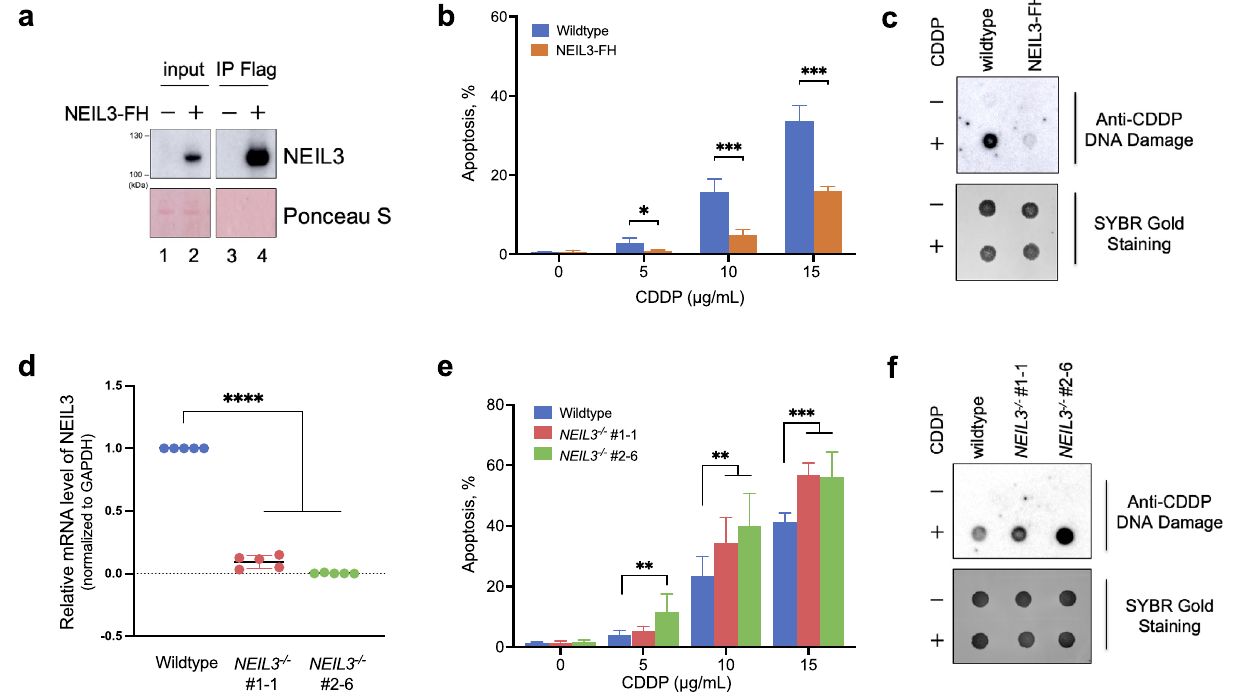
Figure 1. NEIL3 is involved in the repair of cisplatin-induced DNA lesions and protects human cells from cisplatin-induced apoptosis. ( a ) Western blot of Flag IP samples purified from HeLa S3 cells overexpressing NEIL3 protein (NEIL3-FH). Ponceau S staining was used as a loading control. Note that the membrane was cropped to remove irrelevant parts. ( b ) Measurement of apoptosis by flow cytometry of Annexin V and Propidium Iodide (PI) stained cells incubated overnight in the presence of different doses of cisplatin (CDDP). Data shown are the mean ± SD (n = 4). * p < 0.05; ** p < 0.01; *** p < 0.001. ( c ) Dot blot with an antibody recognizing cisplatin-modified DNA to measure the accumulation of cisplatin–DNA adducts after overnight exposure to cisplatin (15 µg/mL). SYBR Gold staining was used as a loading control. ( d ) Characterization of the HeLa S3 NEIL3-/- cell lines constructed using CRISPR-Cas9 genome editing technique. The disruption of the NEIL3 gene in clones #1–1 and #2–6 was confirmed by RT-qPCR. Data shown are the mean ± SD (n = 5). **** p < 0.0001. ( e, f ) Same as in “b” and “c” panels except that HeLa S3 NEIL3 -/- cells were used. See Materials and Methods for additional